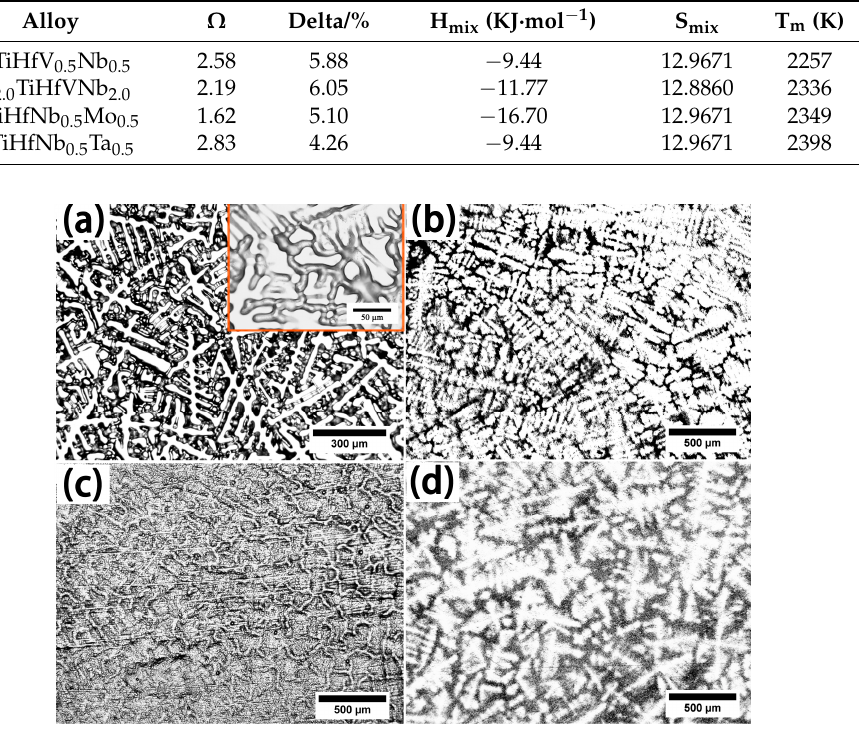
Figure 2. The microstructures of the as-cast RHEAs after being etched: ( a ) ZrTiHfV 0.5 Nb 0.5 ; ( b ) Zr 2.0 TiHfVNb 2.0 ; ( c ) ZrTiHfNb 0.5 Mo 0.5 ; ( d ) ZrTiHfNb 0.5 Ta 0.5 . Table 1. The relevant thermodynamic parameters and valence electron concentration (VEC) of the refractory alloys.